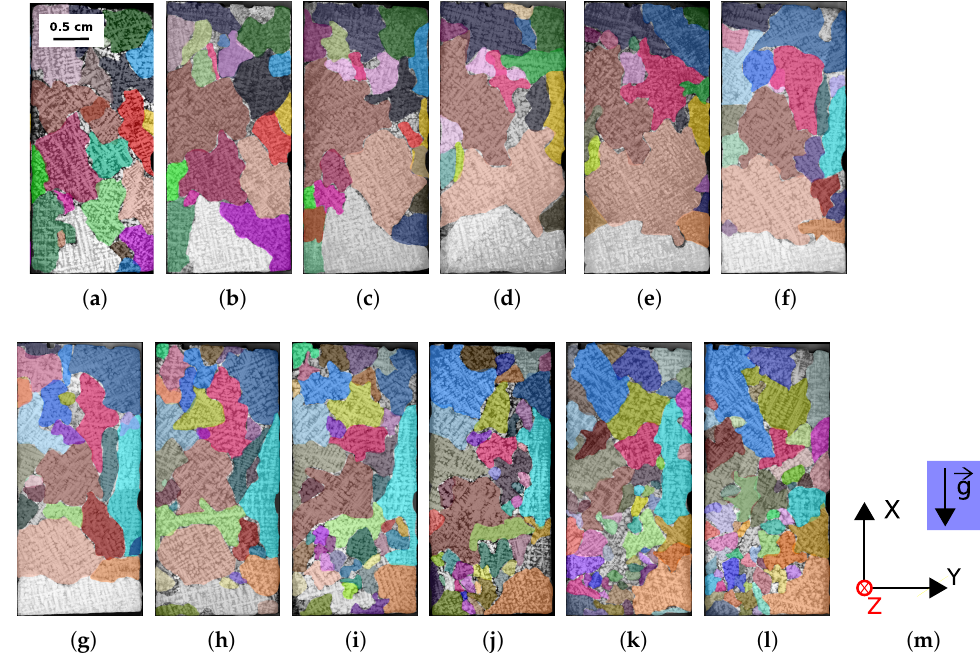
Figure 2. Solidification microstructure after FiJi processing. In the web version, each grain maintains the same color through all slices. ( a ) Z = 0cm; ( b ) Z = 0.11cm; ( c ) Z = 0.22cm; ( d ) Z = 0.33cm; ( e ) Z = 0.44cm; ( f ) Z = 0.55cm; ( g ) Z = 0.66cm; ( h ) Z = 0.77cm; ( i ) Z = 0.88cm; ( j ) Z =